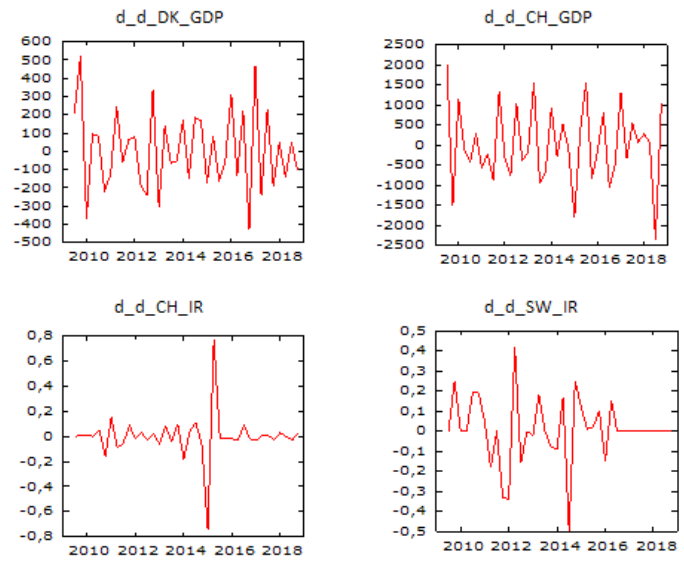
Figure 1. The course of development of the time series – the second difference